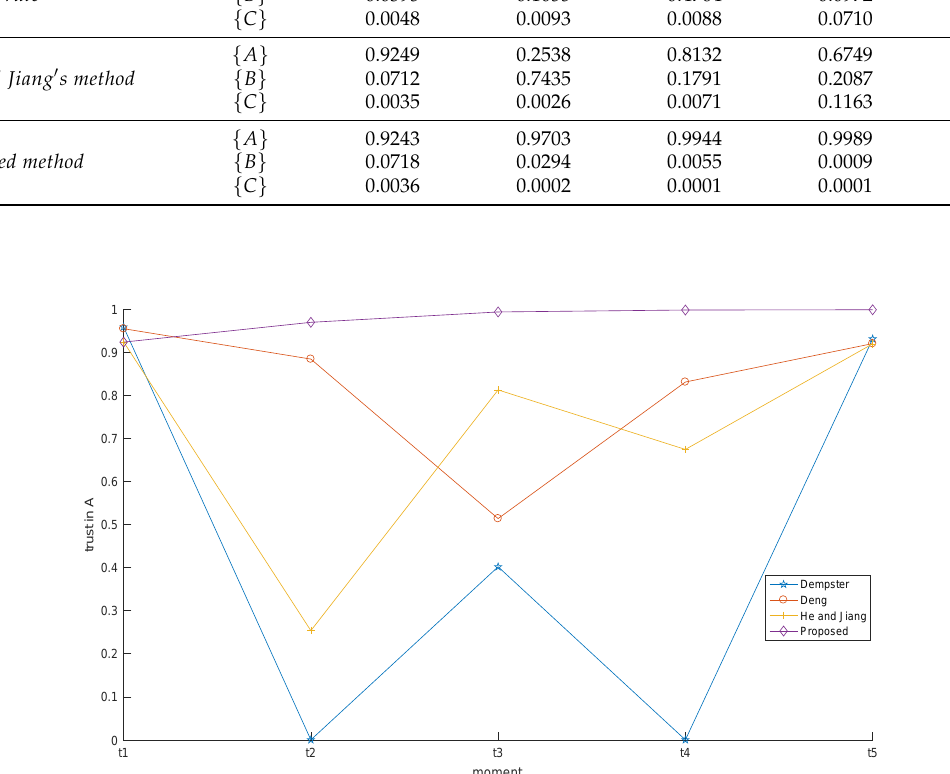
Figure 9. The trend of the results at five moments when the target moves along a straight